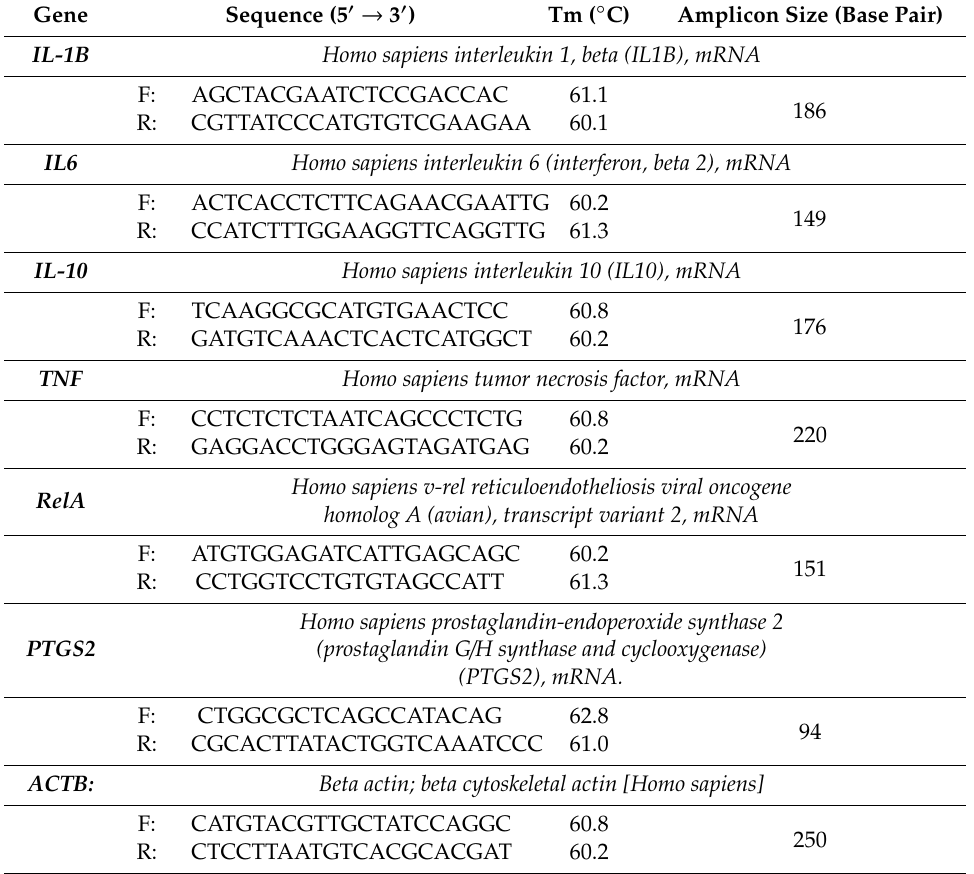
Table 2. Primers sequences use in real-time PCR